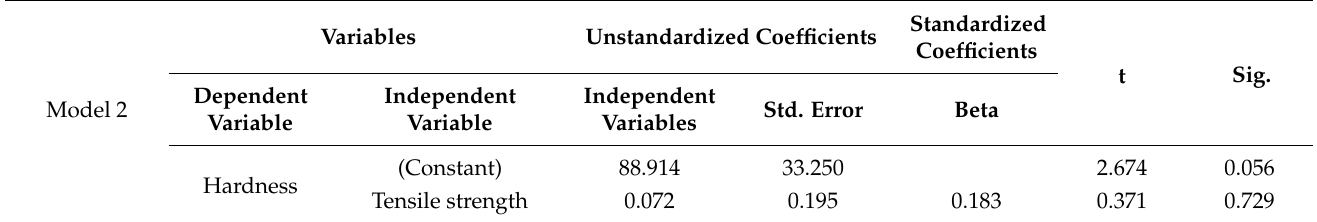
Table A5. Linear relationship between hardness and tensile